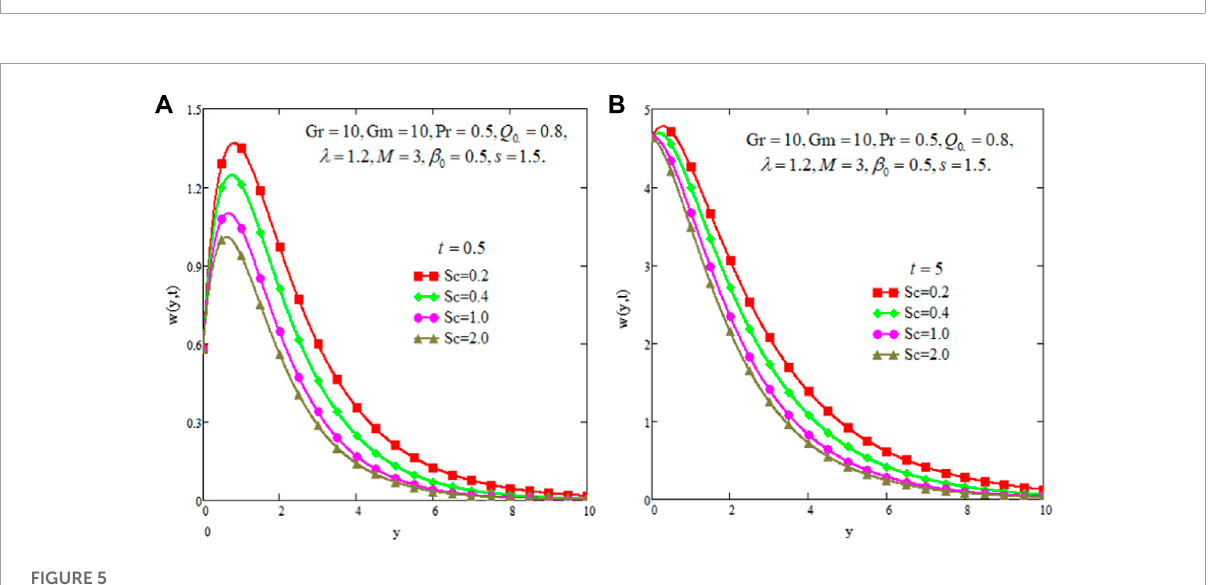
FIGURE 5 Velocity due to Sc for small time (A) and for large time (B)